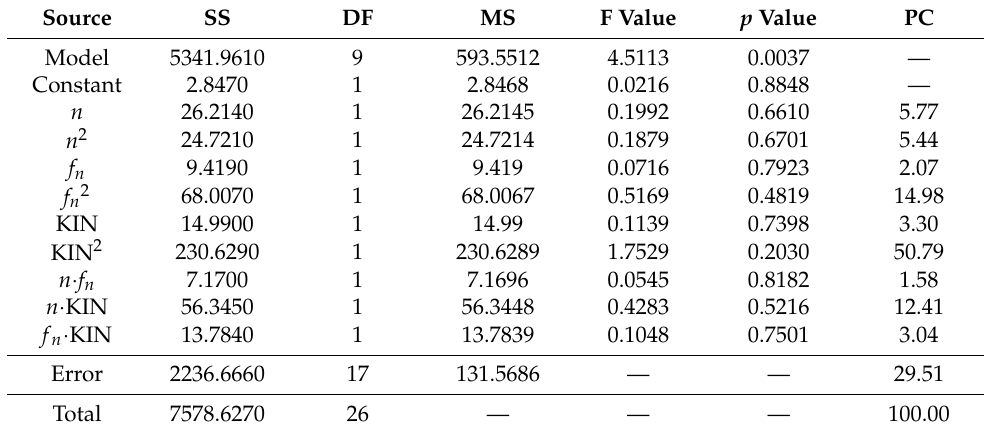
Table 6. ANOVA results for the cylindricity error.